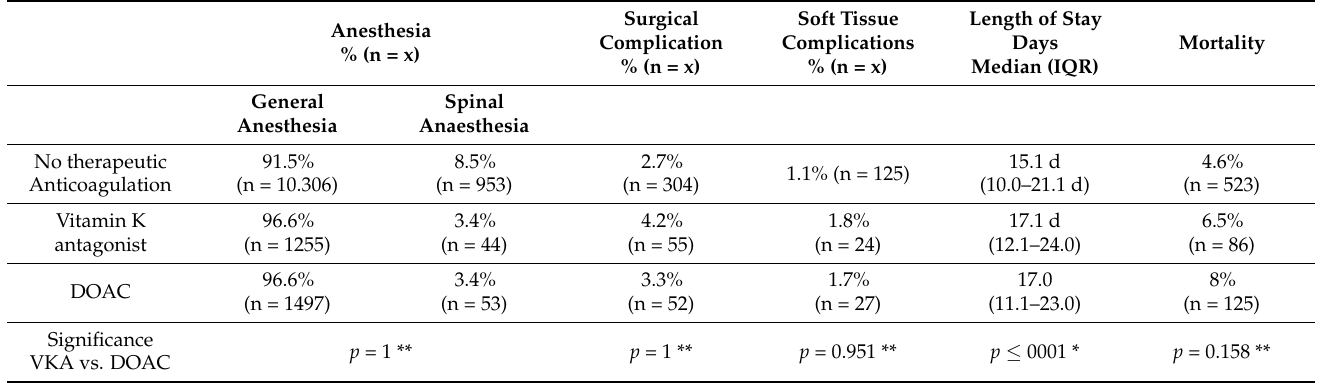
Table 2. Comparison of anesthesia, surgical complications, soft tissue complications, length of stay and mortality during inpatient stay in patients without anticoagulation, under VKA and under DOACs. Surgical Soft Tissue Length of Stay Anesthesia Complication Complications Days Mortality % (n = x) % (n = x) % (n = x) Median (IQR) General Spinal Anesthesia Anaesthesia